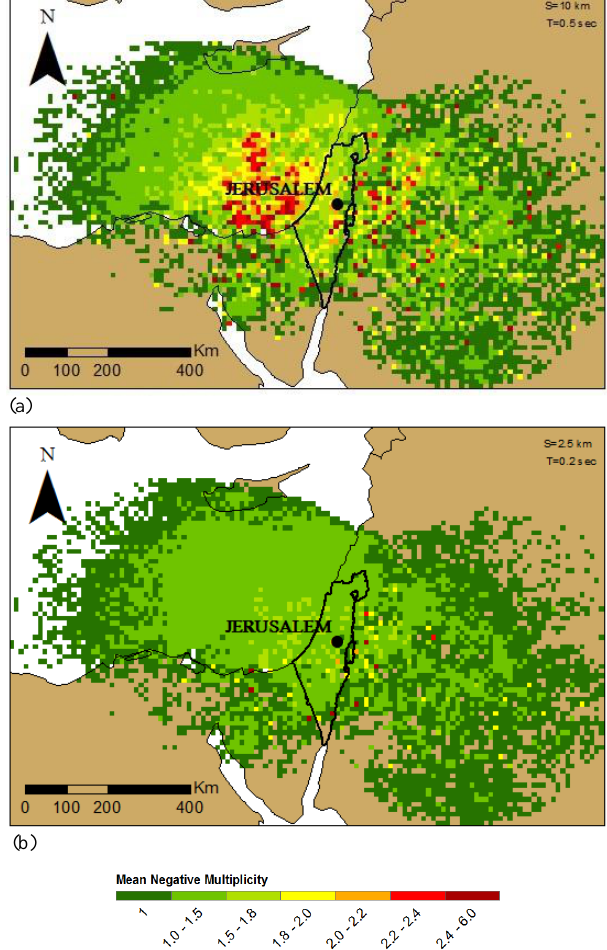
Fig. 4. (a) The negative ground flash multiplicity for thresholds of 0.5s and 10km. (b) The negative ground flash multiplicity for thresholds of 0.2s and